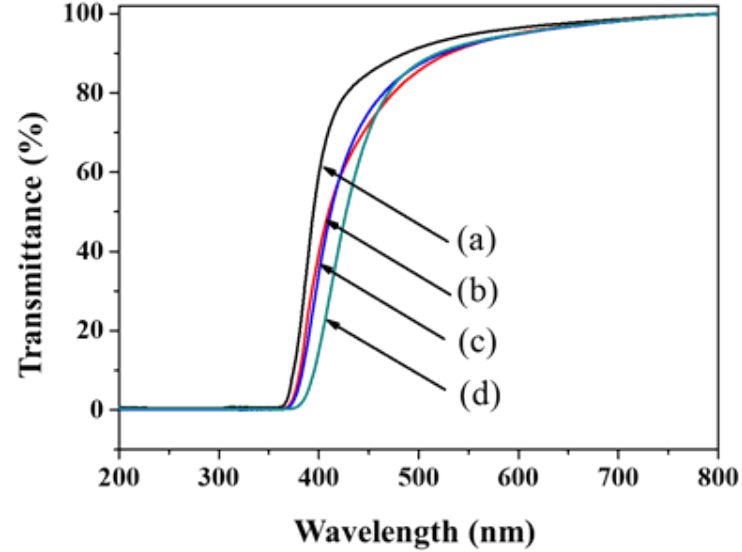
Figure 4. UV spectra of the pure PI and PI–silica composite films with various APTMS contents: (a) pure PI, (b) PI–silica-2.5, (c) PI–silica-5.0, and (d) PI–silica-10.0 films.